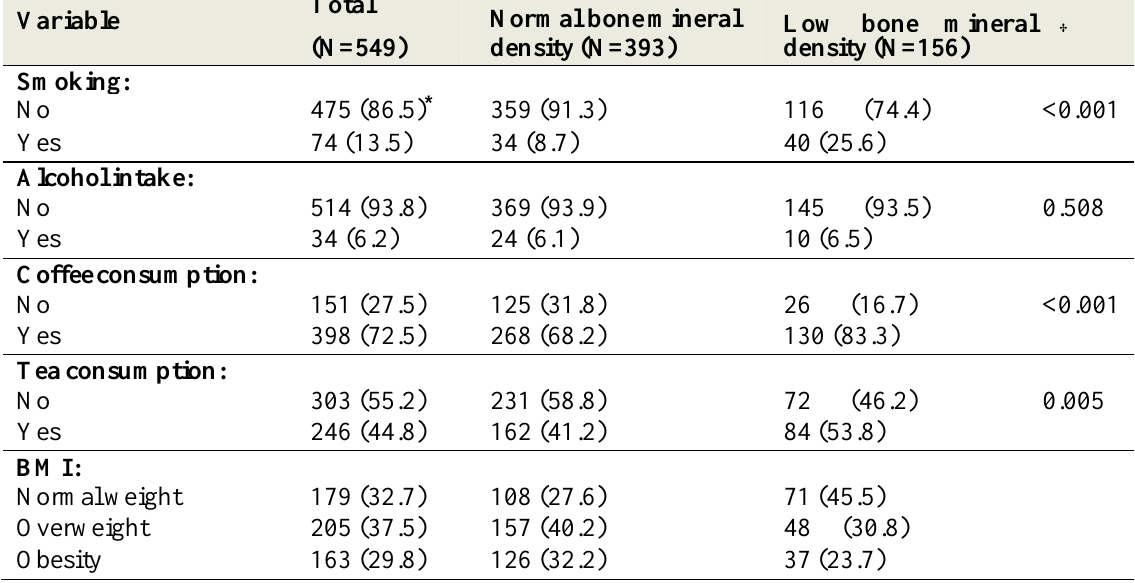
Table 1. Distribution of lifestyle/behavioral factors in a sample of Albanian womenby bone mineral density